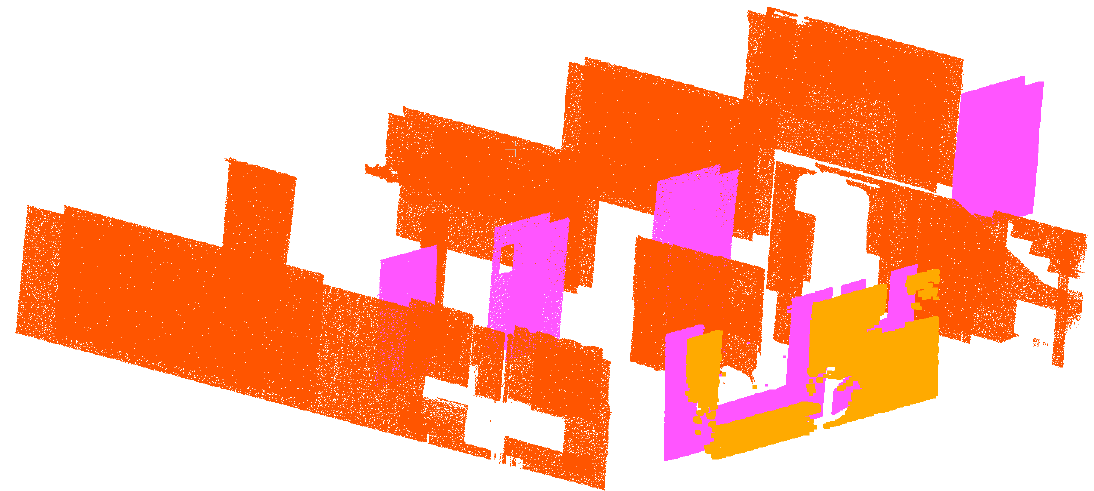
Figure 22. The detected walls from the 1st story.